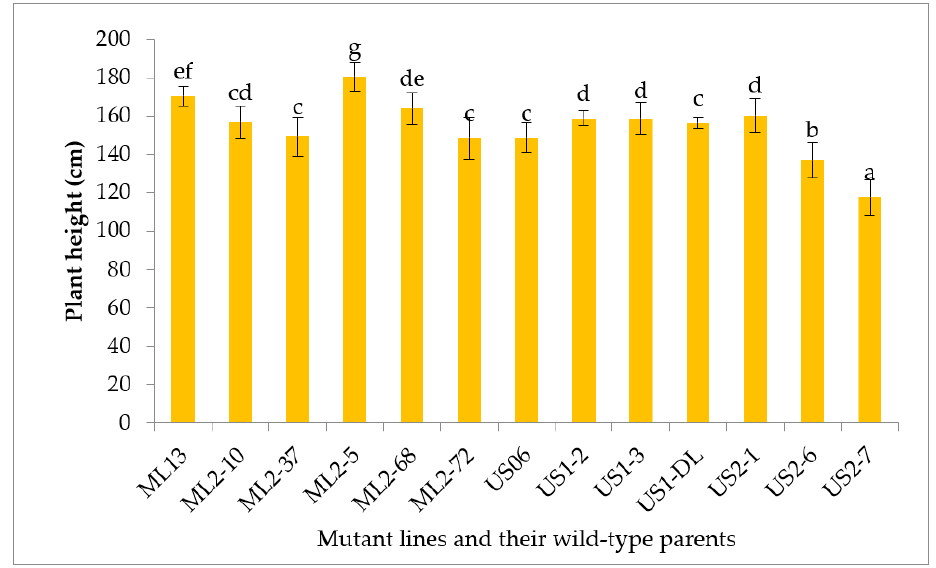
Figure 4. Plant height (PH) in 11 sesame mutant lines and their two wildtypes (US06 and ML13). The superscript letters represent the groups according to Duncan’s test.